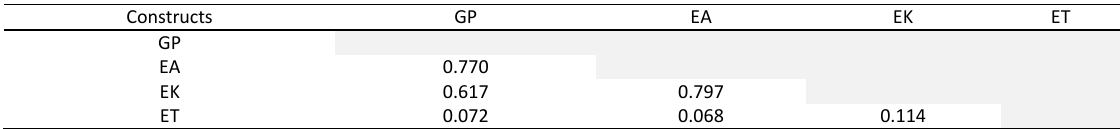
Table 3: Discriminant validity (HTMT ratio)